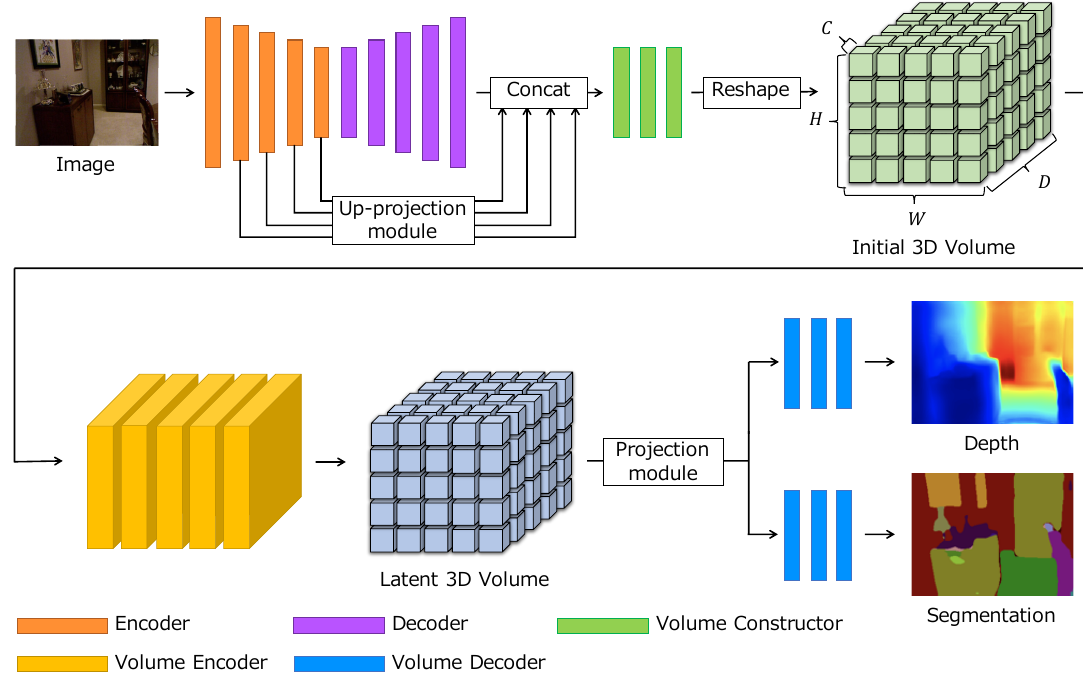
Figure 2. Overall architecture of our